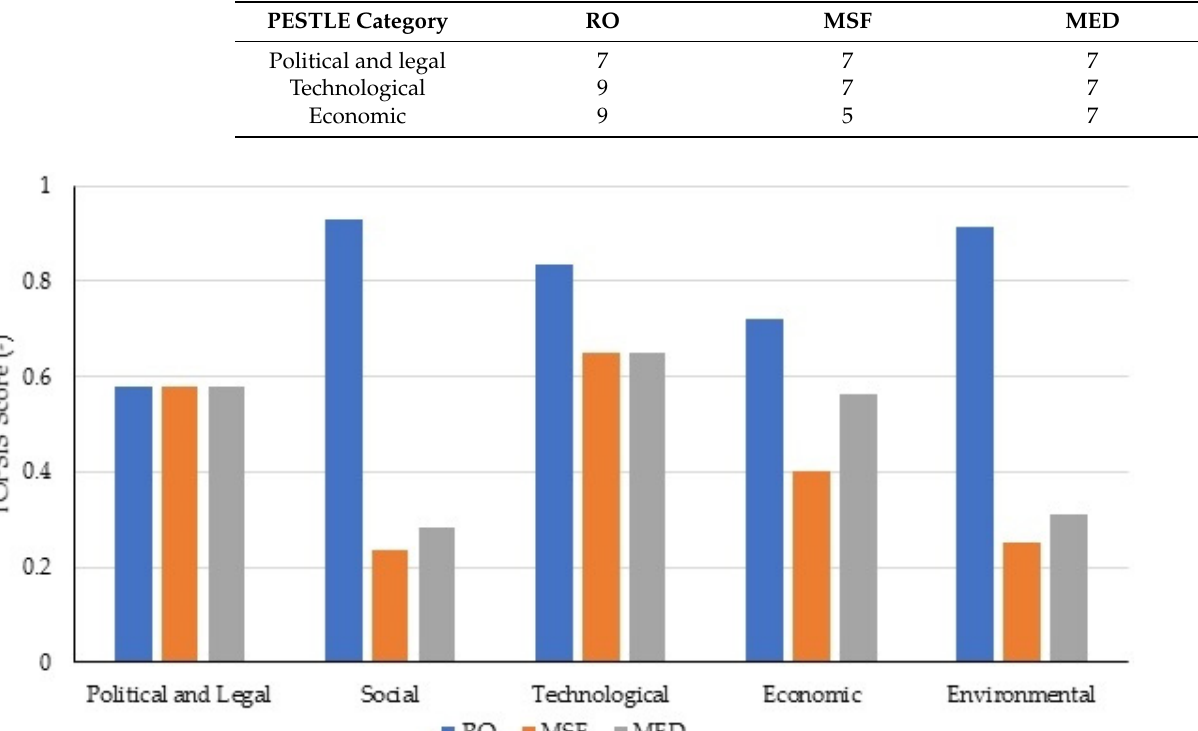
Figure 15. MCDA results of the PESTLE factors with TOPSIS score—the higher, the better.